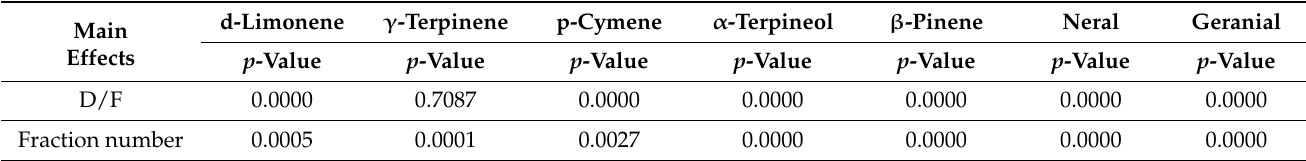
Table 3. Effect of the D/F ratio on the contents of d-limonene, γ -terpinene, p-cymene, α -terpineol, and β -pinene in the distilled